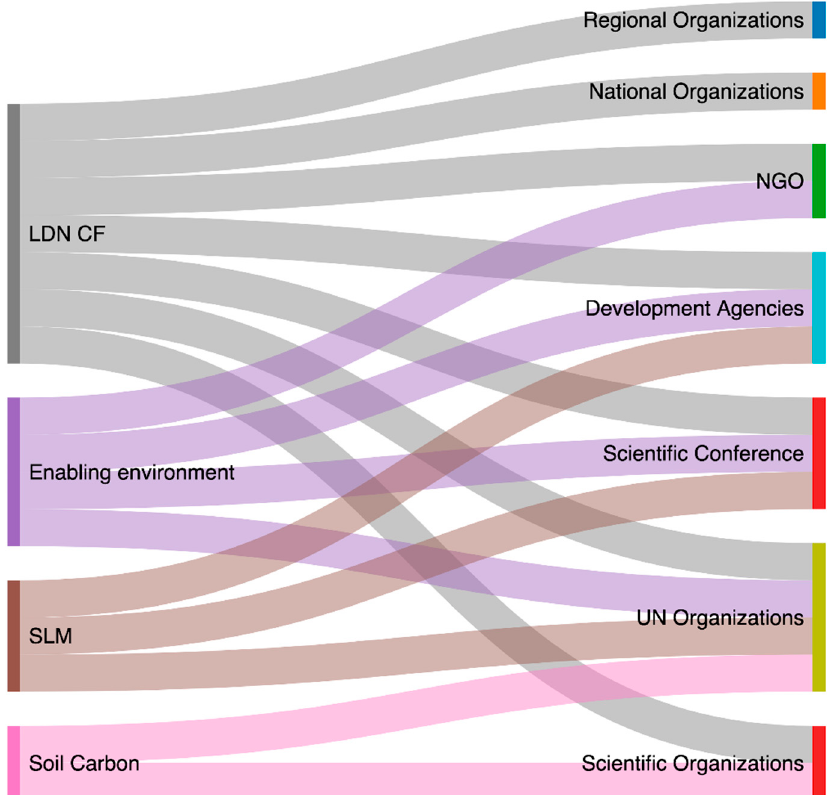
Figure 5. Uptake of the four SPI technical reports by various governmental and non-governmental organizations. LDN CF = [20]; Enabling environment = [39]; SLM (sustainable land management) = [40]; Soil carbon =[41]. For additional details on the uptake of these technical reports, see Table S7a–c.